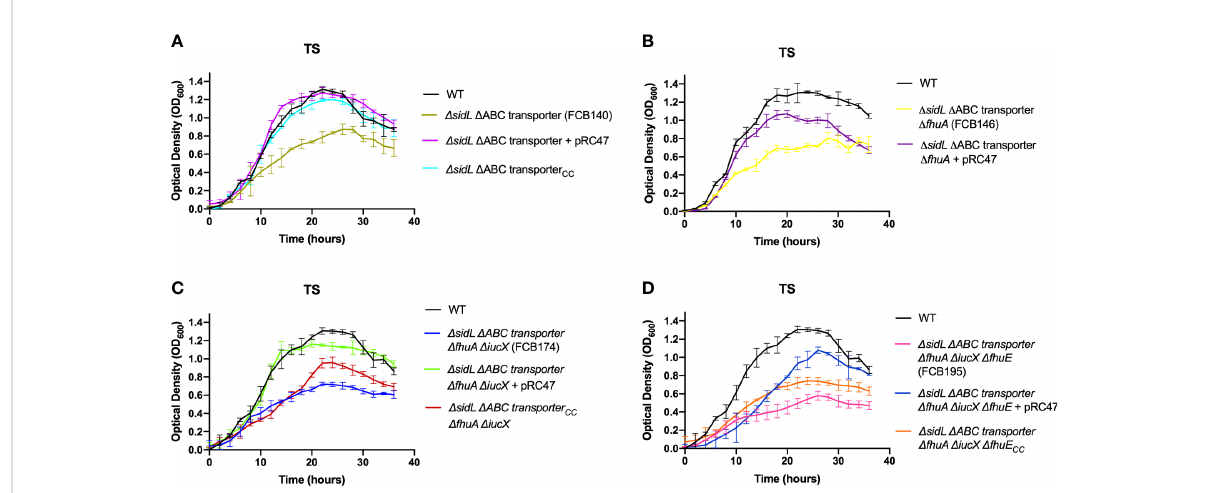
FIGURE 5 Growth of F. columnare wild type, mutants predicted to be de fi cient in multiple steps of iron uptake, and complemented mutants in iron- limited (TS) medium. (A) Wild type (WT), D sidL D ABC transporter mutant (FCB140), FCB140 complemented with pRC47 (expresses the iron ABC transporter genes), and FCB140 complemented by inserting the ABC transporter genes back into the chromosome ( “ CC ” indicates the gene(s) inserted into the chromosome). sidL is a roughly 14 kbp region containing genes involved in siderophore synthesis, export, and regulation that was previously studied (Conrad et al., 2022). Signi fi cant differences in peak cell density were seen between the WT and FCB140 (P < 0.0001). (B) Wild type, D sidL D ABC transporter D fhuA mutant (FCB146), and FCB146 complemented with pRC47. Signi fi cant differences in peak cell density were seen between the WT and FCB146 (P < 0.0001), WT and complemented mutant (P < 0.01) and FCB146 and complemented mutant (P < 0.001). (C) Wild type, D sidL D ABC transporter D fhuA D iucX mutant (FCB174), FCB174 complemented with pRC47, and FCB174 complemented by